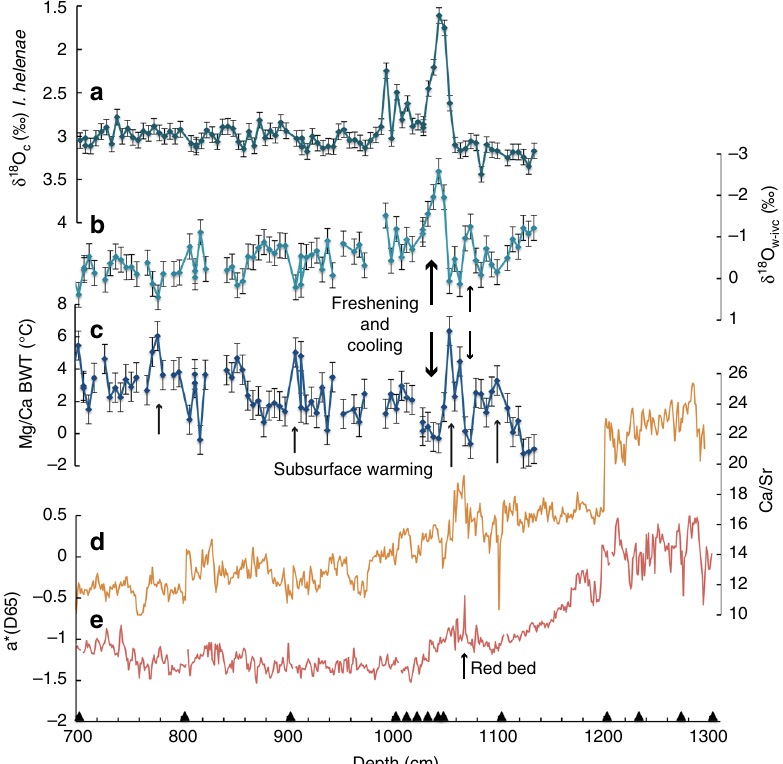
Fig. 2 Depth pro fi les of multiple proxies in core MSM45-19-2. a Stable oxygen isotopes, δ 18 O c , of benthic foraminifera I. helenae displayed with ±0.09 ‰ uncertainty. b Temperature and ice-volume corrected seawater δ 18 O w-ivc displayed with ±0.31 ‰ uncertainty. c Mg/Ca bottom water temperatures displayed with ±0.9 °C uncertainty. d Ca/Sr ratios re fl ect in fl ux of detrital carbonate. e a*(D65) indicates red sediment color. Black triangles mark the